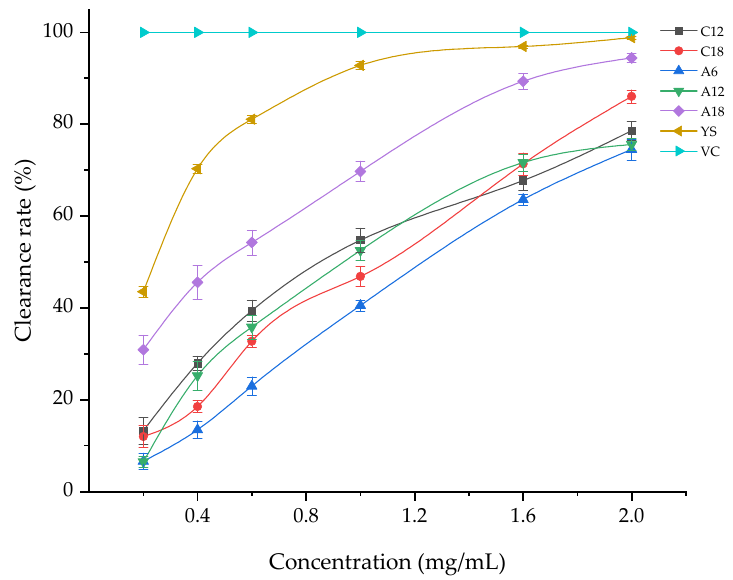
Figure 3. ABTS + free radical clearance rate variation with extract concentration (C12 and C18 represented agarwood produced by A. crassna after 12 and 18 months of inoculation, respectively; A6–A18 represented agarwood produced by A. sinensis after 6, 12, and 18 months of inoculation, respectively; YS and VC represented wild agarwood and ascorbic acid, respectively).